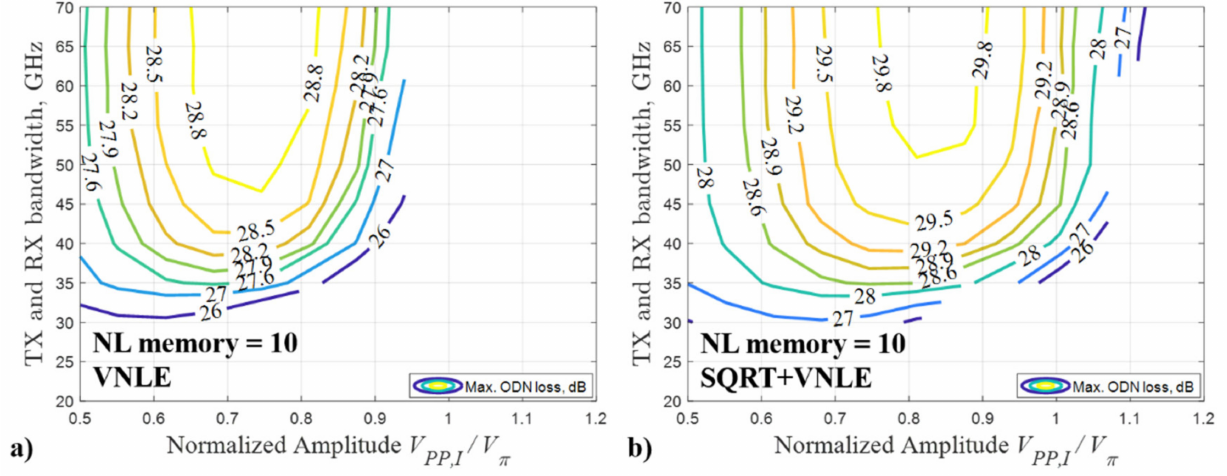
Figure 3. Maximum ODN loss at BER T = 10 − 2 as a function of TX and RX bandwidth and of the normalized peak-to-peak amplitude of the in-phase signal V PP , I / V π with NL memory = 10 samples. The fiber length is L = 20 km. The transmitted optical power is TOP = 15 dBm: ( a ) VNLE; and ( b ) SQRT +